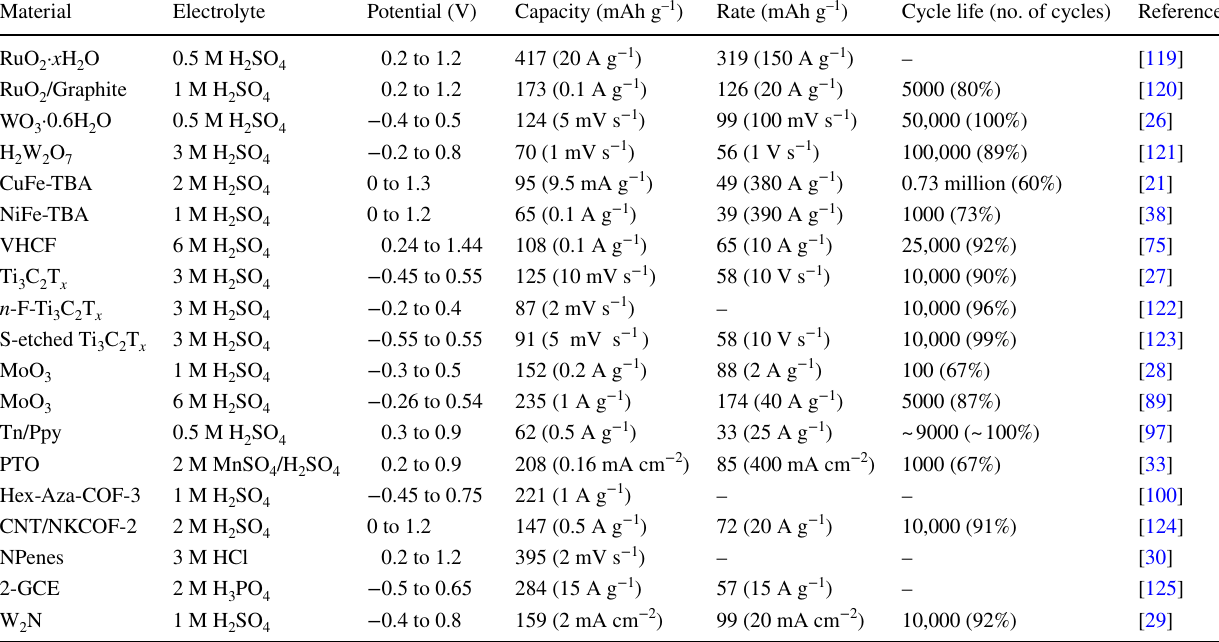
Table 1 Summary of electrode materials for electrochemical proton storage